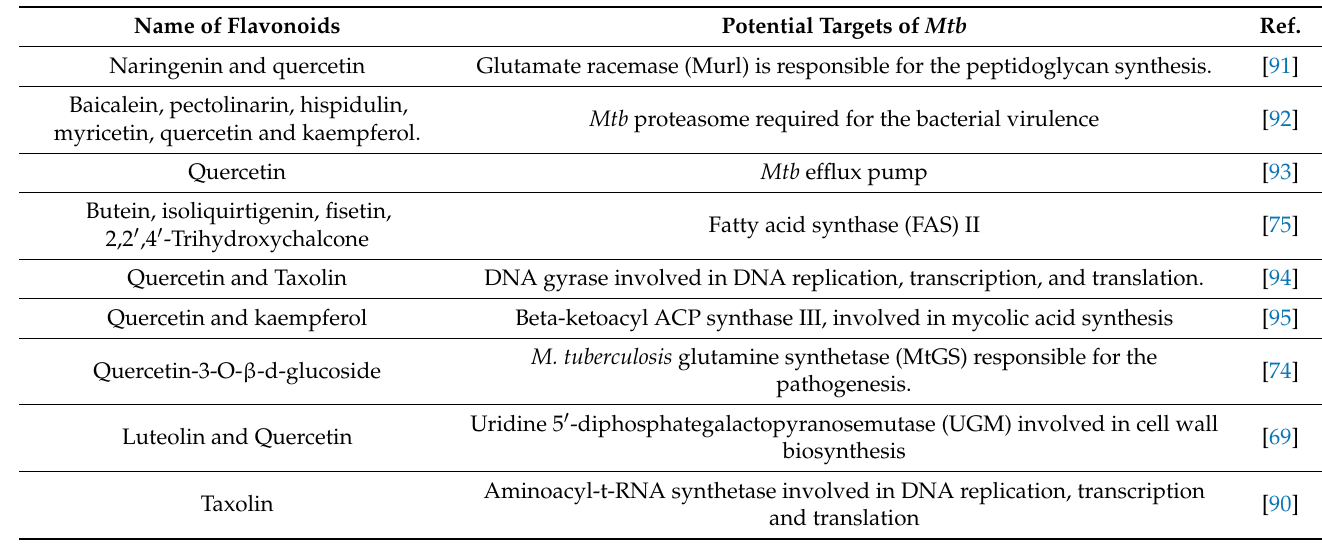
Table 4. List of flavonoids inhibiting potential